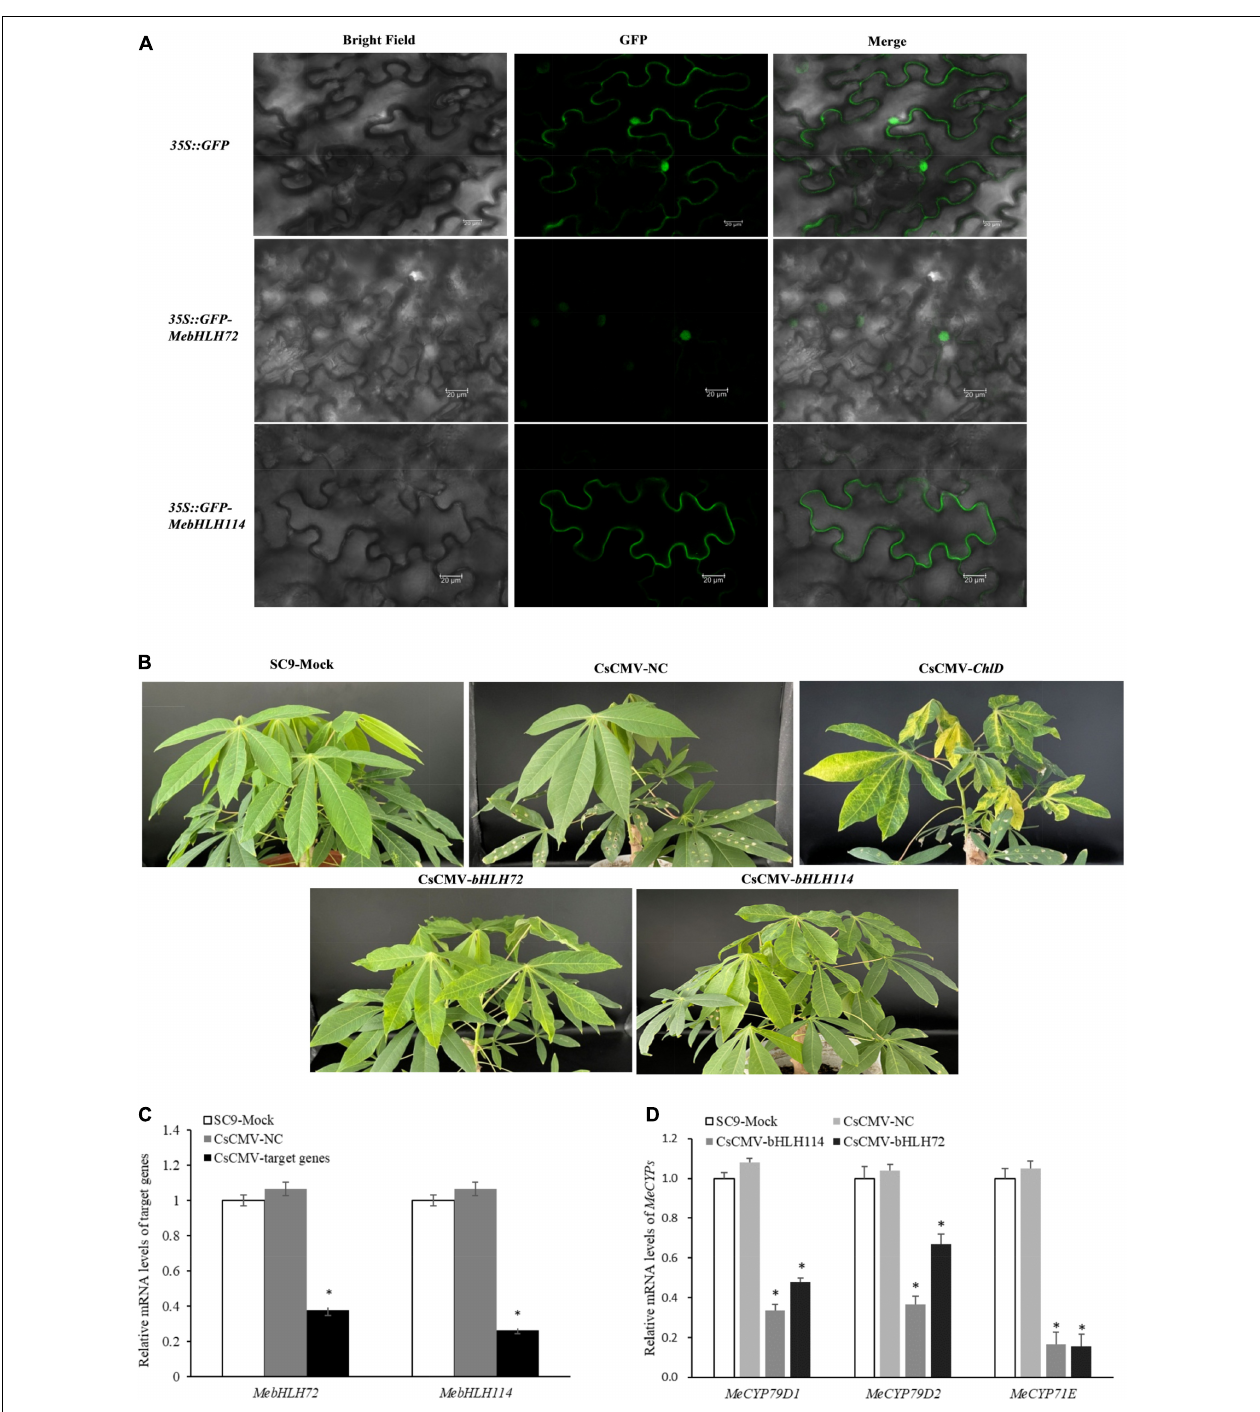
FIGURE 8 | Subcellular localization and Silencing of MebHLH72, MebHLH114 using the pCsCMV- bHLH72 and pCsCMV- bHLH114. (A) Subcellular localization of MebHLH72 and MebHLH114 in tobacco leaves. Bars = 20 µ m. (B) Silencing phenotypes in M. esculenta using the pCsCMV- bHLH72 and pCsCMV- bHLH114 at 40 dpi. SC9-Mock means no infected plant, pCsCMV-NC means infected with non-target control CsCMV-NC. (C) qRT-PCR analyses of MebHLH72 and MebHLH114 mRNA expression in M. esculenta infected with pCsCMV- bHLH72 and pCsCMV- bHLH114 . The no infected plant was used as control. Three independent experiments were performed and each included six plants per treatment group. Error bars indicate the standard deviation. (D) qRT-PCR analyses of MeCYP79D1, MeCYP79D2 and MeCYP71E mRNA expression in M. esculenta infected with pCsCMV- bHLH72 and pCsCMV- bHLH114 . The no infected plant was used as the control. Three independent experiments were performed and each included six plants per treatment group. Error bars indicate the standard deviation.